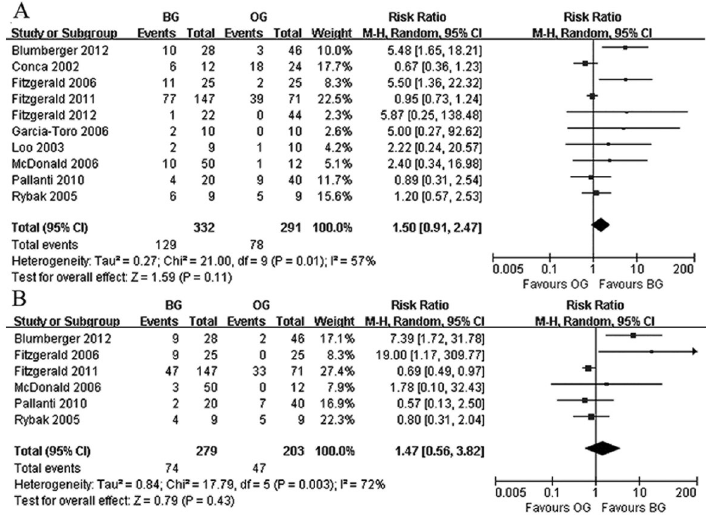
Figure 2. Primary outcome and secondary out- come: bilateral rTMS vs other rTMS paradigms. A , Comparison of bilateral rTMS vs other para- digms rTMS for primary outcome: response at end of treatment. B , Comparison of bilateral rTMS vs other paradigms rTMS for primary outcome: remission at end of treatment. rTMS: repetitive transcranial magnetic stimulation; BG: bilateral rTMS treatment group; OG: other rTMS paradigms